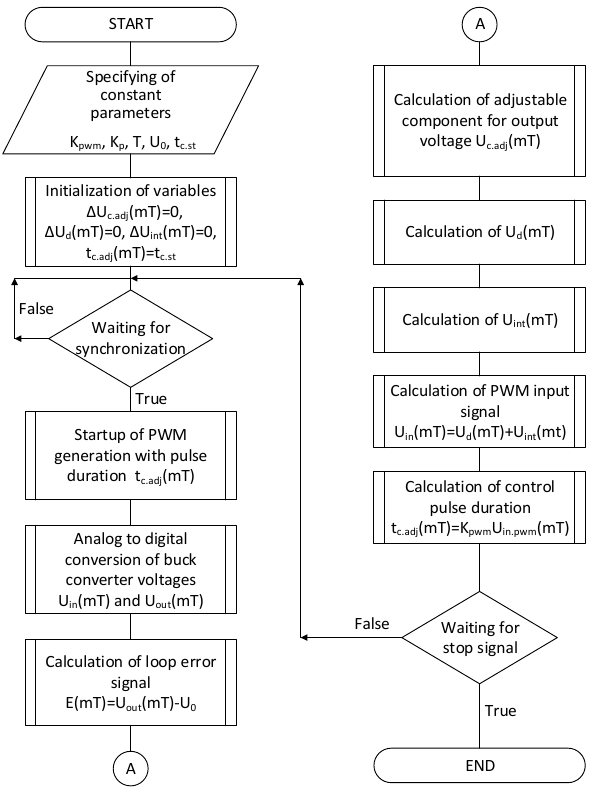
Figure 7. The algorithm of the embedded software for buck converter